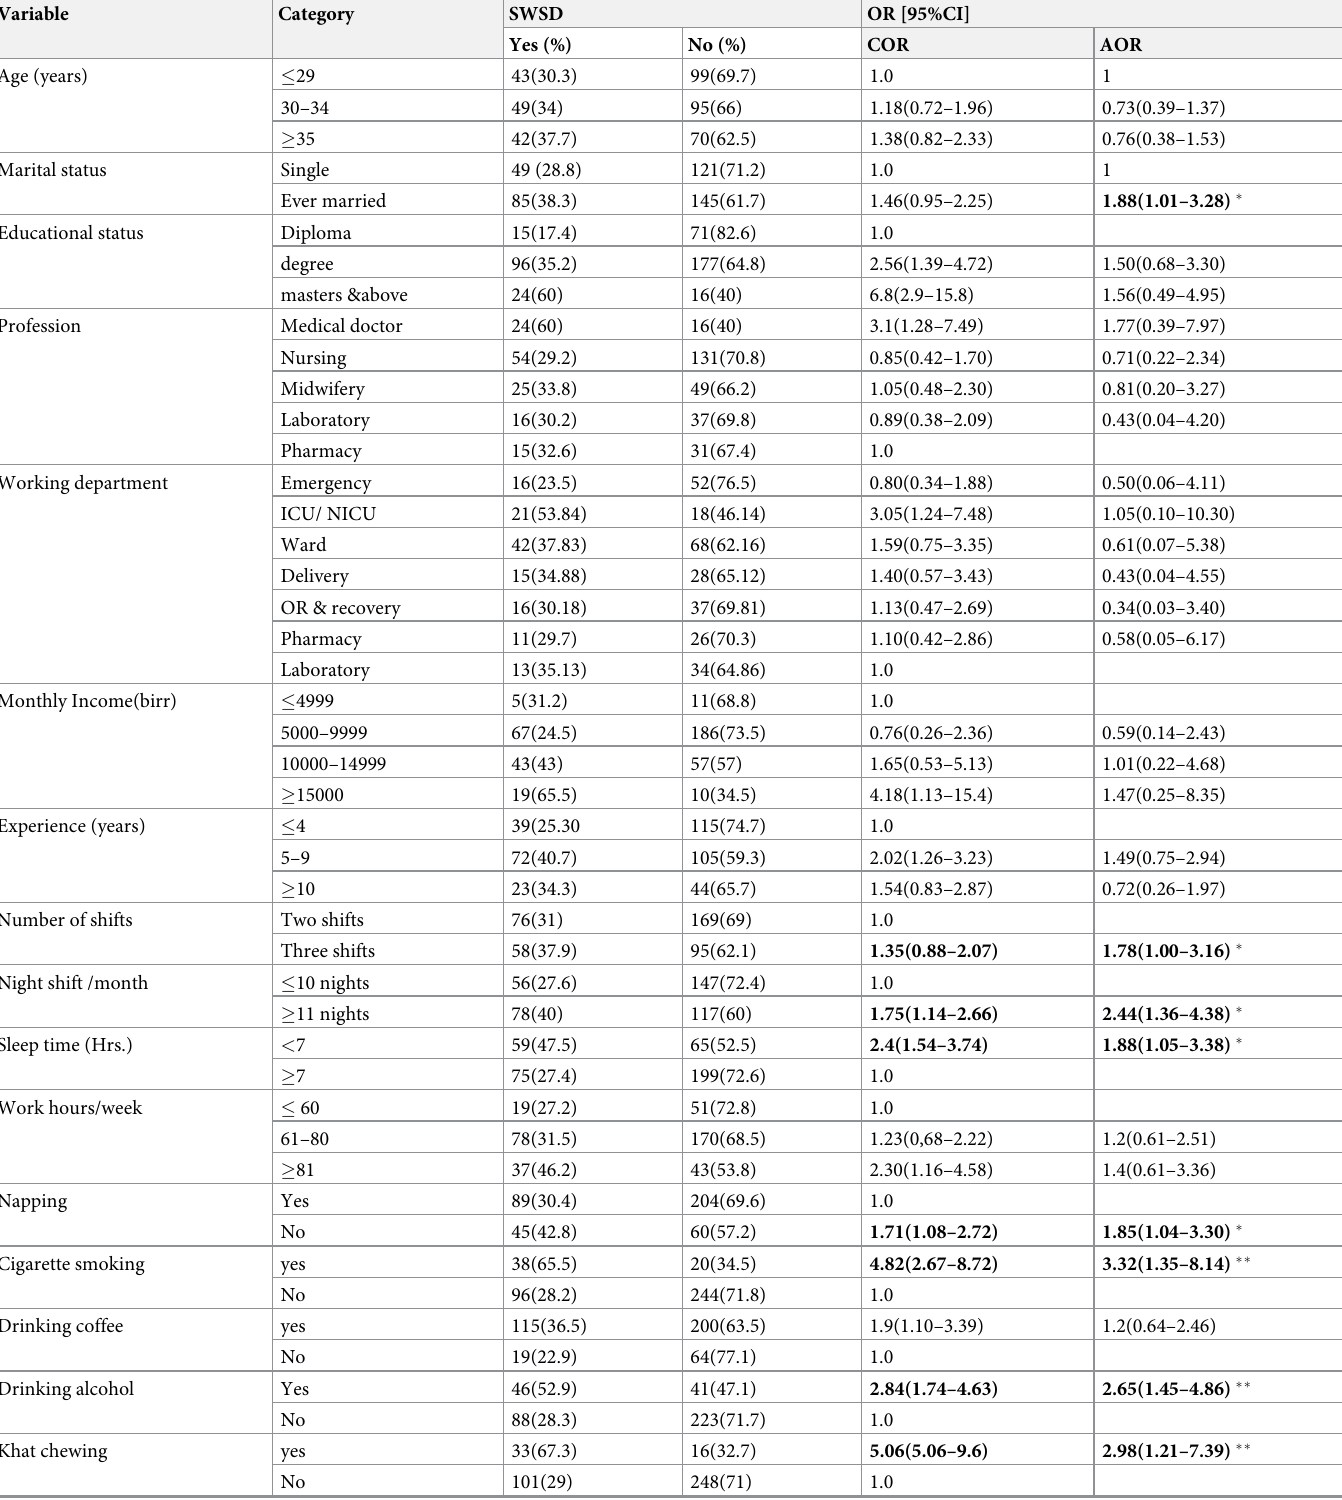
Table 3. Factors associated with SWSD among health care workers working at public hospitals in Sidama regional state, Southern Ethiopia, 2021 (n = 398).